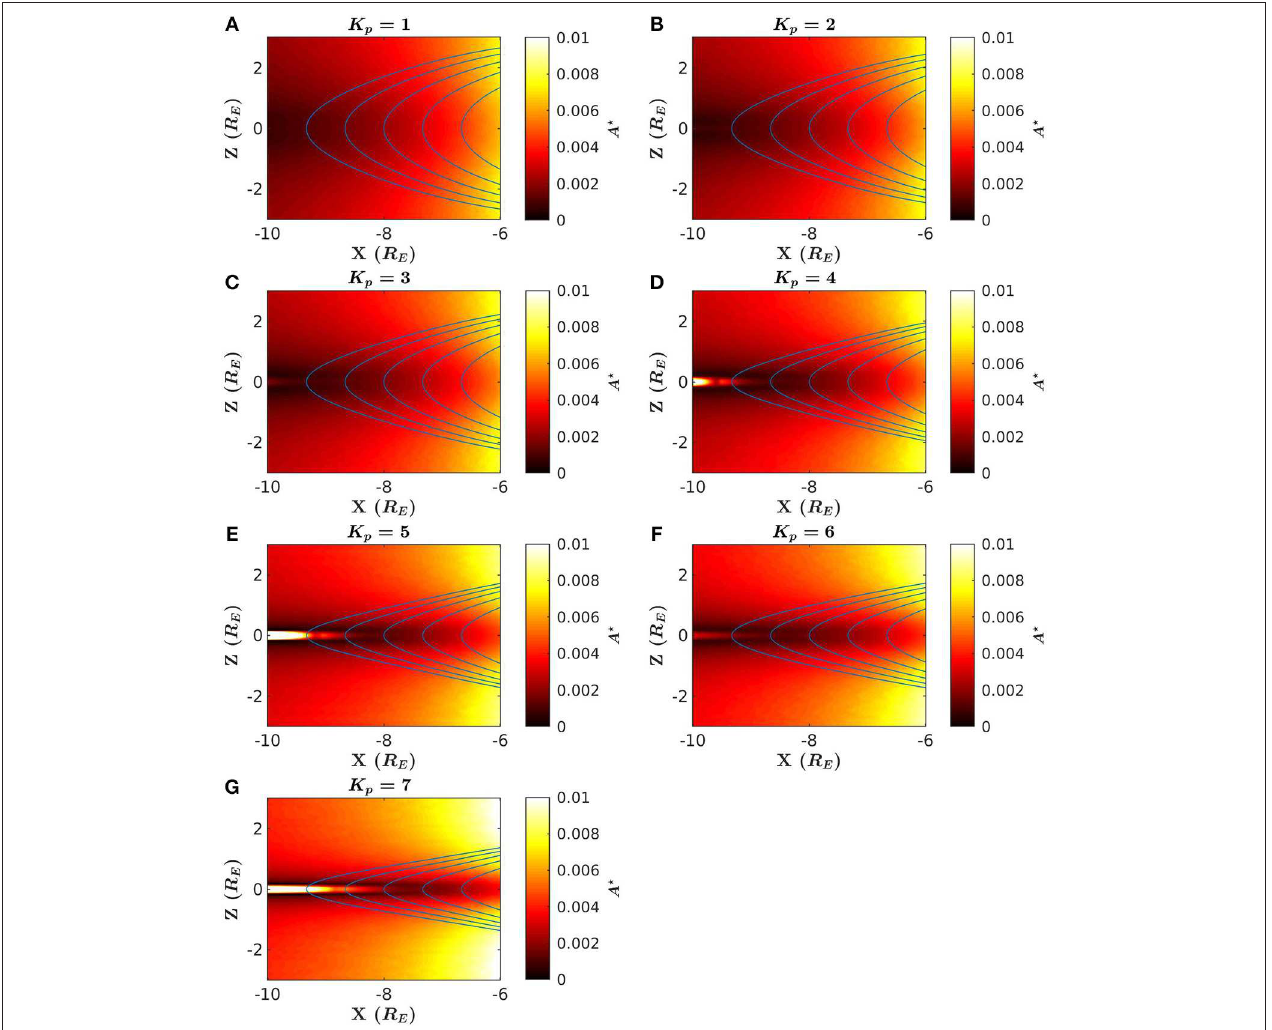
FIGURE 1 | A plotted over midnight local time for various K p assuming a beam energy of 1 MeV: (A) K p (F) K p 6, (G) K p 7. Blue curves represent field-lines that intersect chosen values of X on the equatorial plane. Darker and lighter regions indicate regions with = = smaller and greater values of A , respectively. Note that A is not expected to reflect accessibility at the equatorial plane for high K p